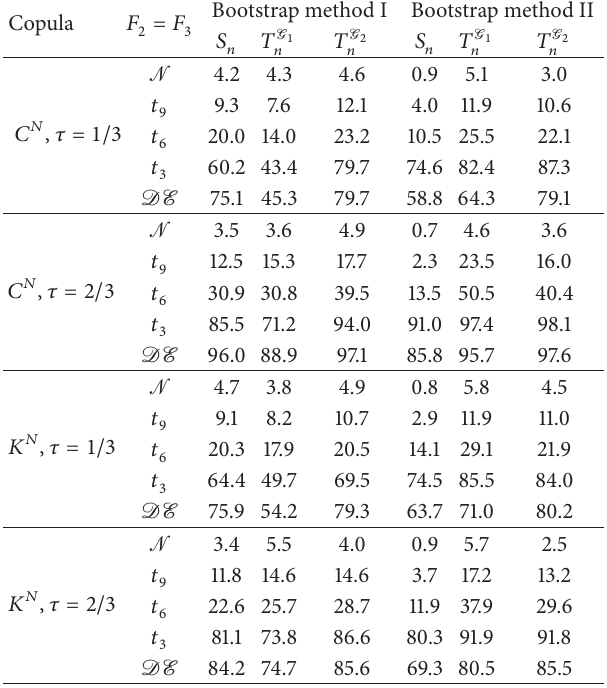
Table 3: Percentages of rejection, as estimated from 1000 replicates, of the null hypothesis of the equality of 𝐾 = 3 distributions up to location/scale under Normal and asymmetric Normal dependence structures when 𝑛 = 200 ; 𝐹 1 is the Normal distribution; 𝐹 2 = 𝐹 3 are either the N , 𝑡 9 , 𝑡 6 , 𝑡 3 , or DE distribution. Copula